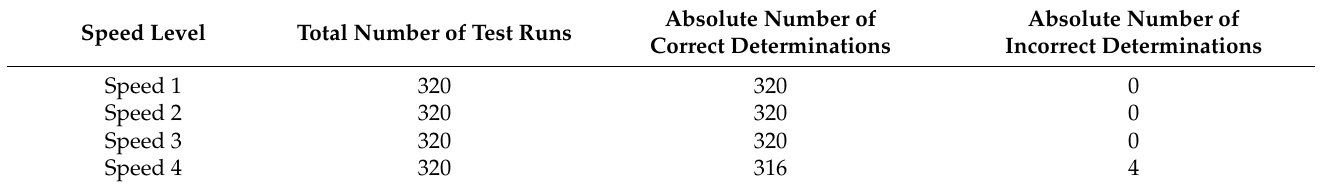
Table 4. Results of the scenario determination for the different speed